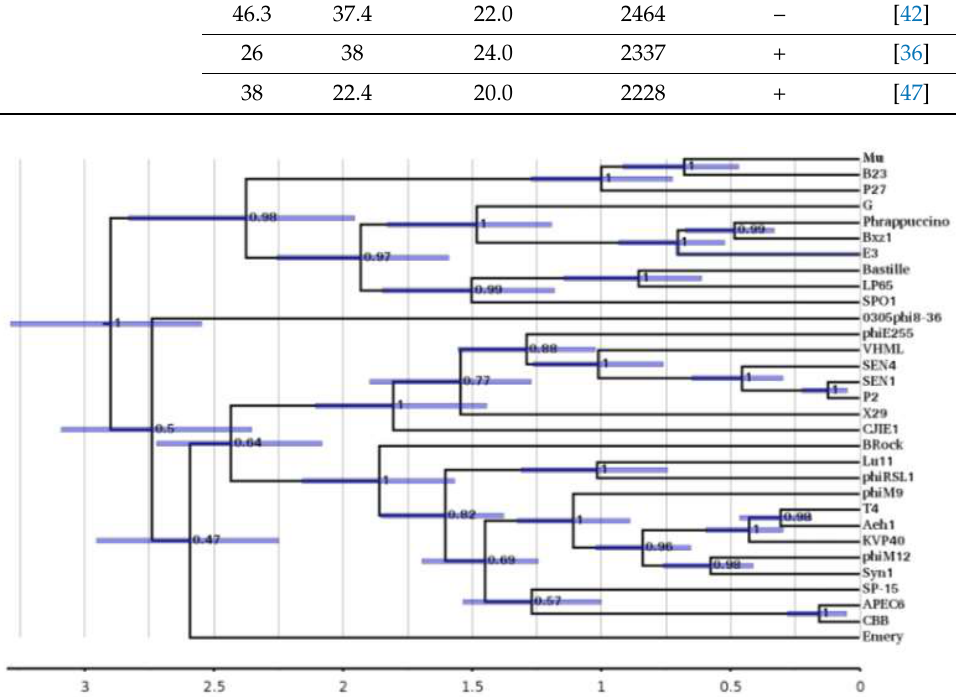
Figure 9. Phage G sheath timetree. A timetree bioinformatic analysis was conducted to analyze the evolutionary relationship among various phage tail sheath proteins (see Materials and Methods). The timeline unit used was 1.0 Gya. The error bars shown in purple report 95% confidence in the height of each node, and are accompanied by the posterior probability that all branches below the node are correctly placed.